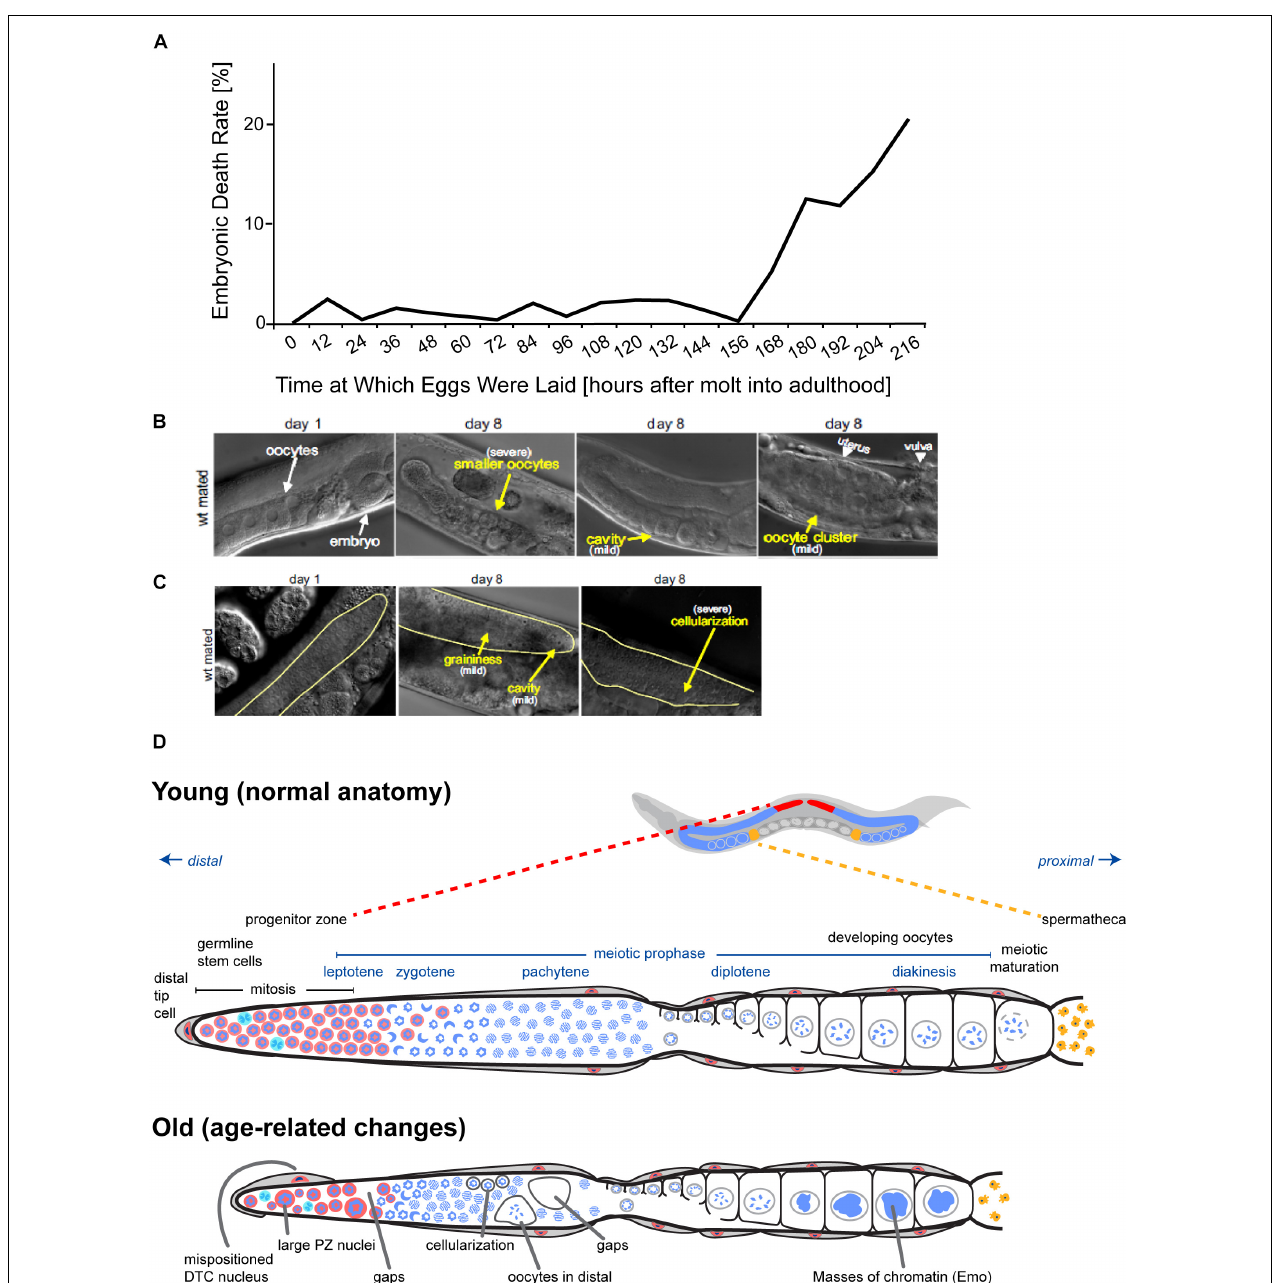
FIGURE 3 | Age-related declines of oocyte and germline quality. (A) fog-2(q71) mutant animals that do not produce self-sperm were mated to males (start: 0 h), and the percentage of unhatched embryos was determined every 12 h. The embryonic death rate displays an age-related increase to ∼ 20% by day 9. Adapted from Andux and Ellis (2008). (B) Oocytes of adult day 8 mated wild-type hermaphrodites display morphological defects visible using differential interference contrast microscopy (DIC). Compared to adult day 1 mated wild-type hermaphrodites, oocytes in adult day 8 hermaphrodites can be smaller, clustered, or contain cavities (yellow arrows). Reprinted from Luo et al. (2010) with permission from Elsevier. (C) The distal germ line of adult day 8 mated wild-type hermaphrodites displays morphological defects visible using DIC microscopy. Compared to adult day 1 mated wild-type hermaphrodites, the distal germ line loses its smoothness in adult day 8 hermaphrodites and can appear grainy with cavities or exhibit severe cellularization (yellow arrows). The morphological defects are defined according Garigan et al. (2002). Reprinted from Luo et al. (2010) with permission from Elsevier. (D) Anatomy of C. elegans germ line in young versus old hermaphrodites. Top: C. elegans hermaphrodites have two U-shaped germ lines (red and blue). The spermatheca is shown in yellow, and the uterus with developing embryos is shown in dark gray. Middle: Diagram of one unfolded young C. elegans hermaphrodite germ line. Nuclear morphology can be visualized by staining DNA with DAPI (blue). The distal progenitor zone (red) contains mitotically cycling stem and progenitor cells. The distal tip cell (DTC) provides the GLP-1/Notch ligand to maintain the stem cell fate of these cells. As cells migrate away from the DTC, they exit the progenitor zone and enter meiotic prophase. Bottom: Diagram of one unfolded old C. elegans hermaphrodite germ line. Numerous age-related changes in the germ line have been reported. Several are illustrated here. Adapted from Kocsisova et al. (2019).